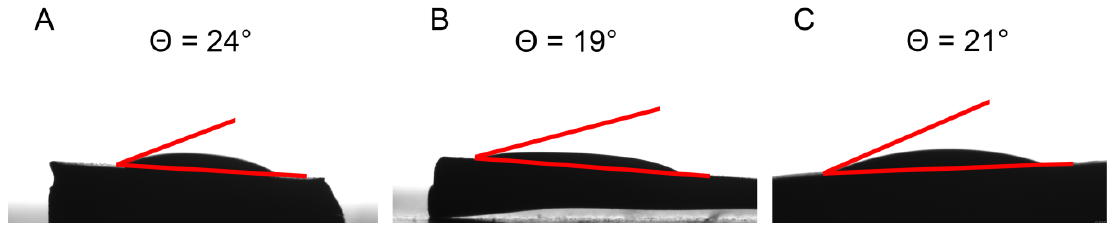
Figure 5. Water drop contact angle measurements of SCCs with different surface modifications ( A–C ).